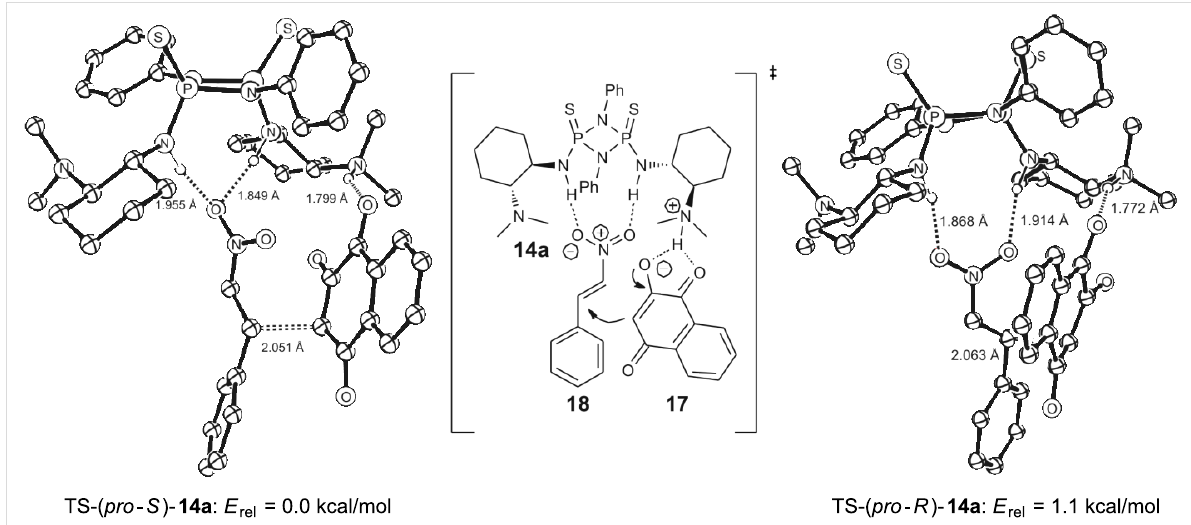
Figure 9: Enantiodetermining transition states TS- 14a /TS- 14b arising from the addition of 2-hydroxynapthoquinone to β -nitrostyrene.